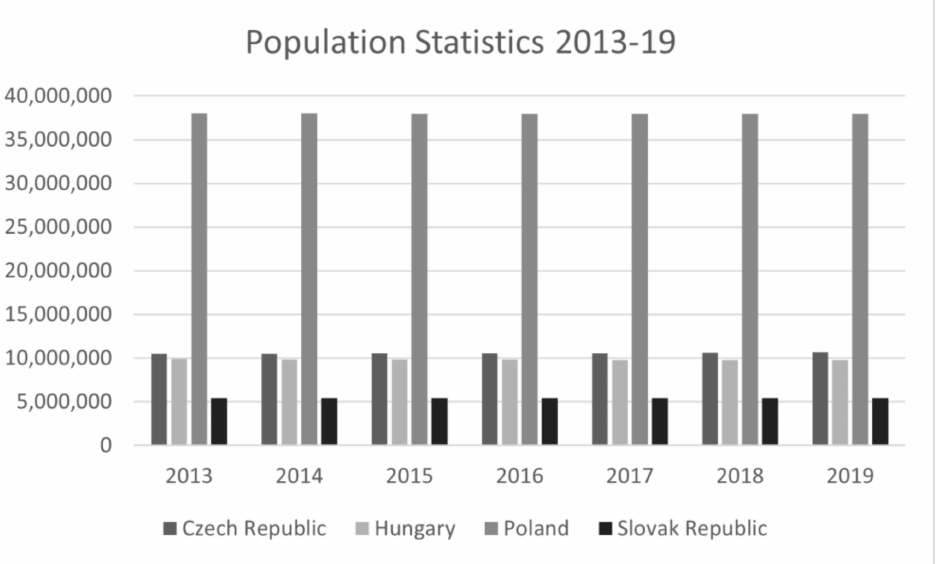
Figure 2. Population data for the Czech Republic, Hungary, Poland, and Slovakia, 2013–2019. In the case of the crime rate for 2013–2019, we observed a somewhat declining trend in all four countries, especially in the case of Slovakia, which showed no fluctuation in the decline. However, Hungary and Poland in 2017 and 2018 showed a slight dip (as can be seen with the negative change of up to 60%) and rise (as can be seen with the negative change of up to 40%) in criminal offences, respectively, showing an overall decline through the years 2013–2019 (Figure 3). Furthermore, Poland recorded the most offences, whereas Slovakia had the least after the Czech Republic and Hungary. Table 2 presents the data on incidents of crime, population, and the calculated crime rates (the sources are given in